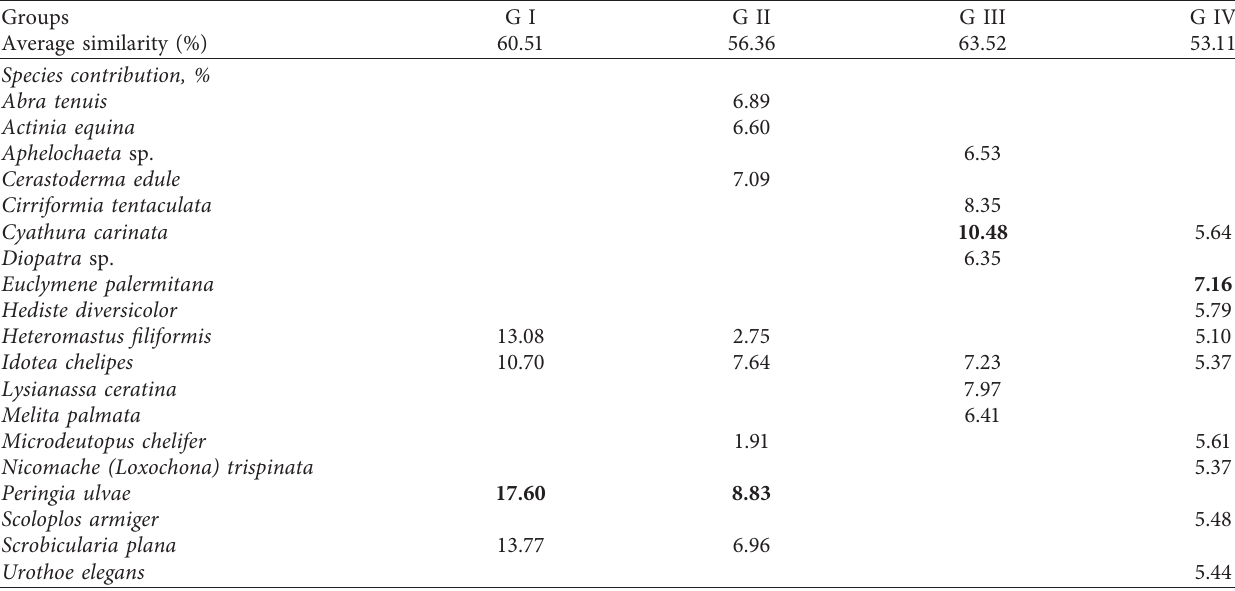
Table 6: Results of SIMPER analysis showing the average similarity within the different benthic assemblages. Assemblages were identified by the hierarchical ascendant classification analysis and the characteristic species of each benthic assemblage.